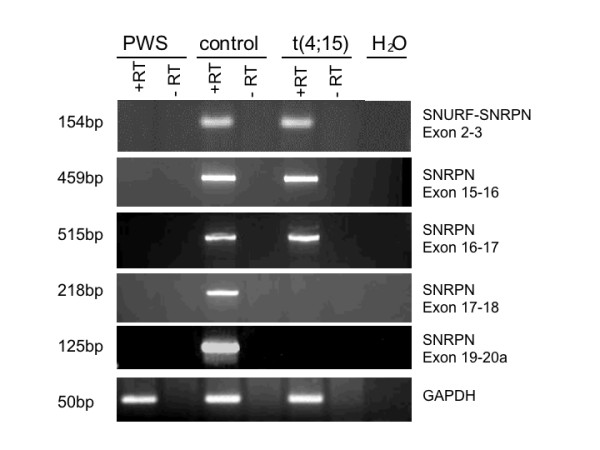
SNRPN expression analysis by RT-PCR of RNA from LCLs . On the left, the sizes of the PCR products are shown, and on the right, the location of the primers in SNRPN exons is listed. +RT: with reverse transcriptase; -RT: without reverse transcriptase; H2O: no template control. All SNRPN +RT products tested were absent in the PWS control, and present in the normal control. The t(4;15) cells were positive for SNURF/ SNRPN exons 2–3, 15–16 and 16–17 and negative for exons 18 through 20a. GAPDH primers were used as control for the integrity of the cDNA.